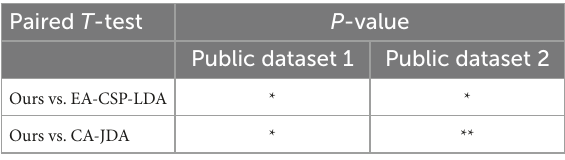
TABLE 3 T -test results for the proposed method vs. state-of-the-art methods. Paired T -test P -value